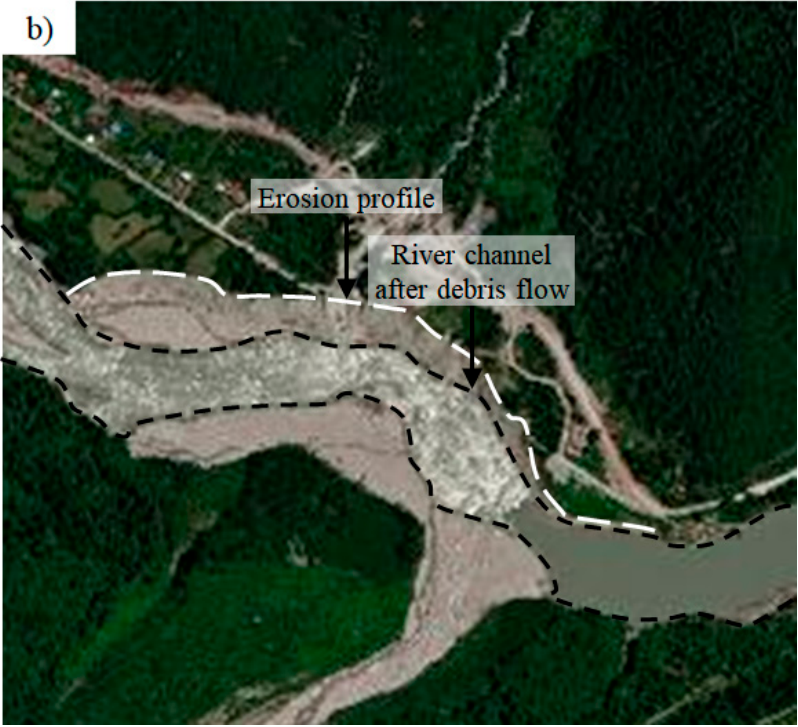
Figure 7. Satellite images: ( a ) 1 December 2010 and ( b ) 27 August 2011. Figure 8. Satellite images: ( a ) 1 December 2010 and ( b ) 27 August